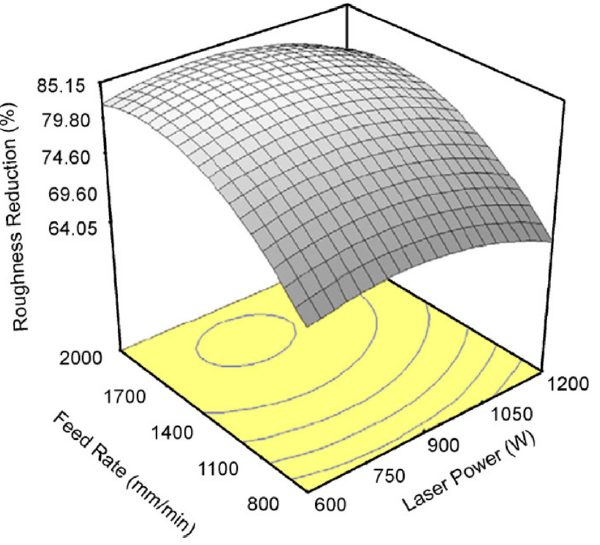
Figure 17. The effect of process parameters in the LF of AM parts [39].